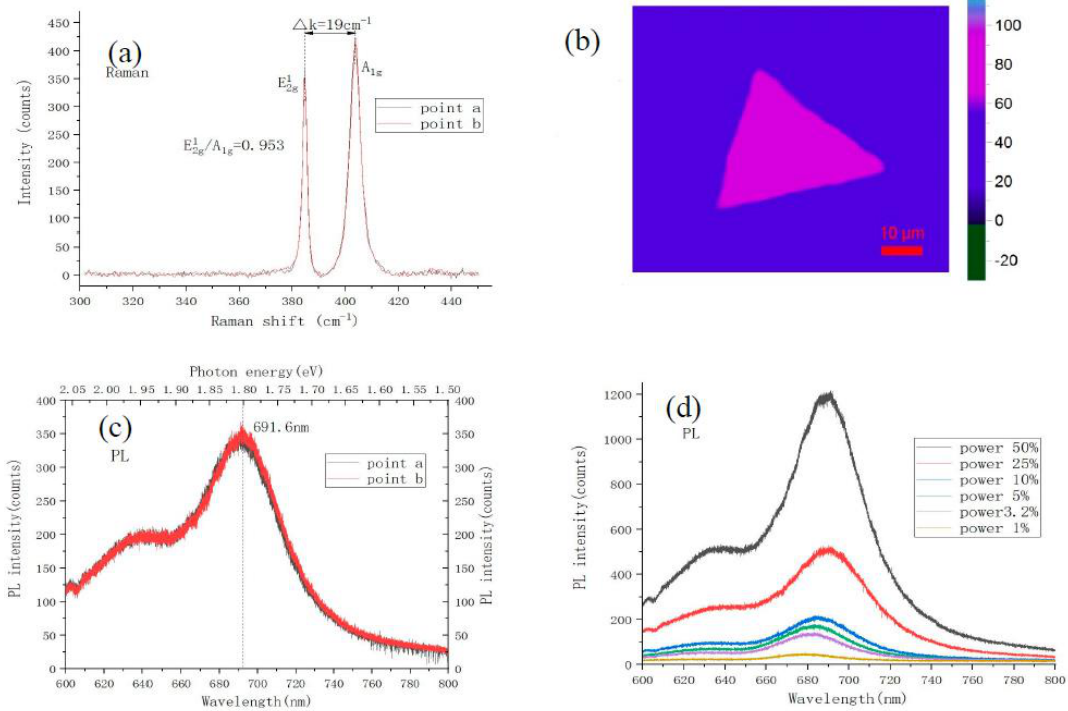
Figure 7. Raman and photoluminescence spectrum of the monolayer MoS 2 . ( a ) is the Raman spectrum of MoS 2 corresponding to Figure 6, wherein the black line corresponds to Figure 6a, and the red line corresponds to Figure 6b; ( b ) is the Raman mapping of A 1g ; ( c ) shows the MoS 2 photoluminescence spectrum corresponding to Figure 6. The black line corresponds to Figure 6a, and the red line corresponds to Figure 6b; ( d ) is the power-dependant PL spectrum under ambient condition.